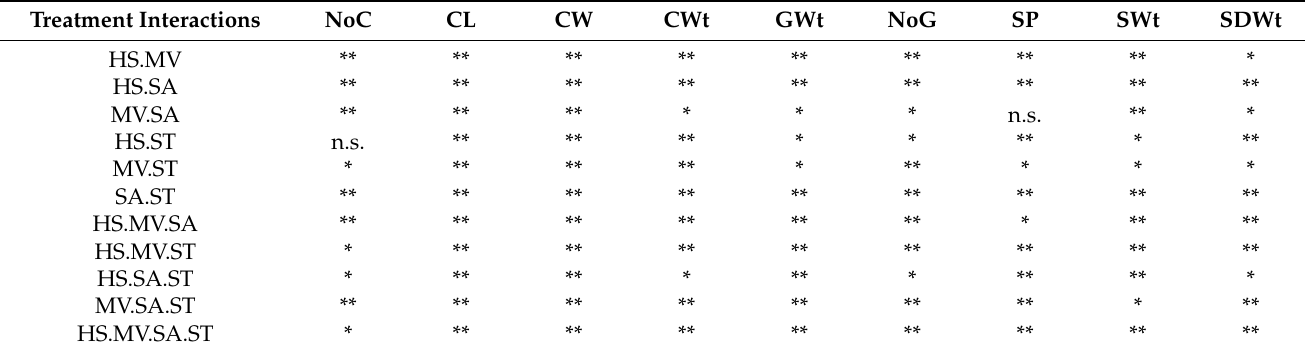
Table 2. First-, second-, and third-order interactions of heat stress, maize variety, soil amendment, and soil type on the maize yield attributes. Treatment